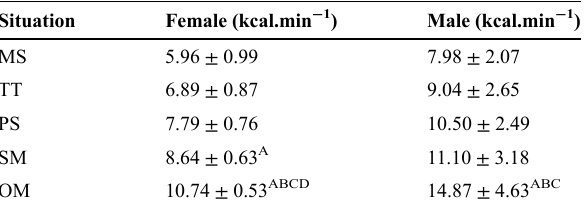
14.87 ± 4.63 ABC MS, multi-shuttlecock training; TT, tactical training; PS, physical train- ing; SM, simulated match; OM, official match. A, significant difference compared to multi-shuttlecock; B, significant difference compared to technical-tactical; C, significant difference compared to physical; D, sig- nificant difference compared to simulated match (p <